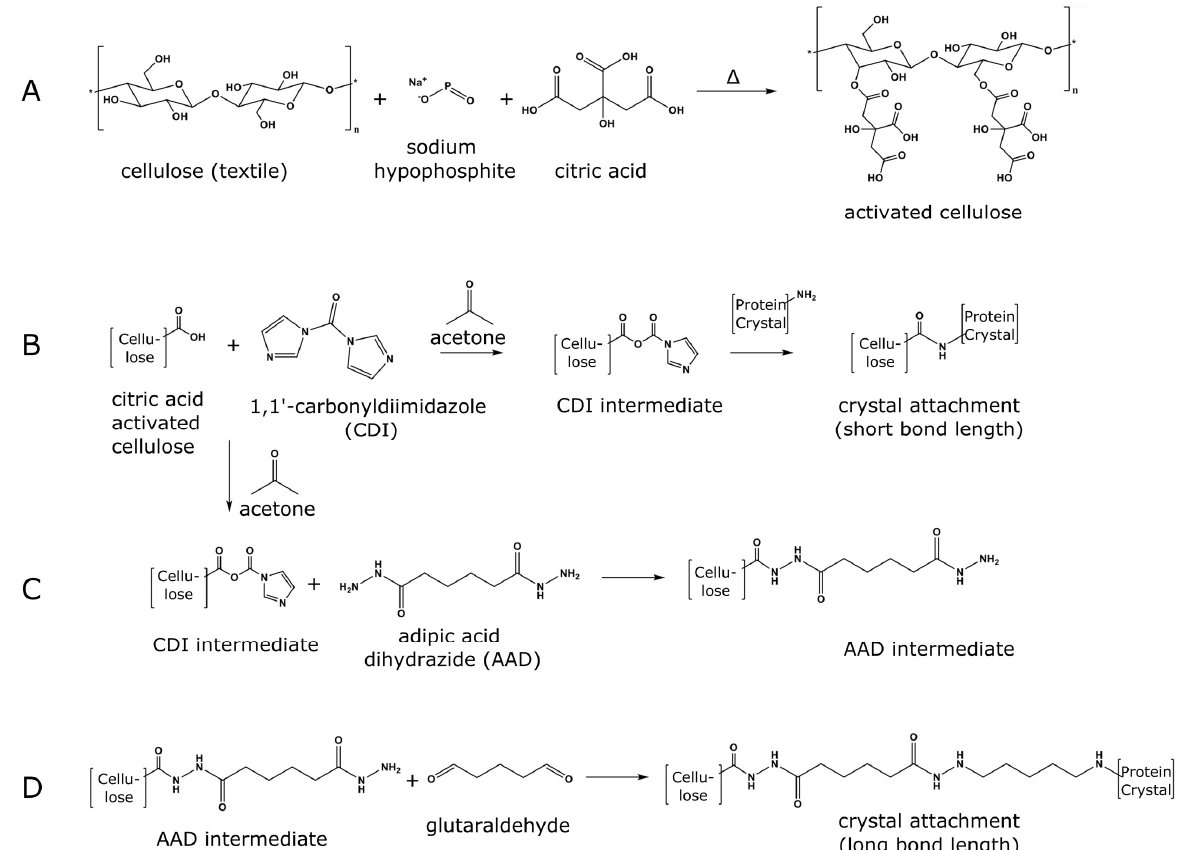
Figure 2. Protein crystal to the fabric attachment chemistries. ( A ) Formation of the surface carboxylic acid groups on the cellulose fabric (* represents the continuing polymer). ( B ) The CDI-only strategy: formation of the CDI intermediate and crystal attachment via pre-existing primary amines on the crystal surface. ( C ) The CDI + AAD + GA strategy: attachment of the AAD linker arm to the CDI intermediate followed by ( D ) crystal attachment to the AAD intermediate textile via glutaraldehyde cross-linking.